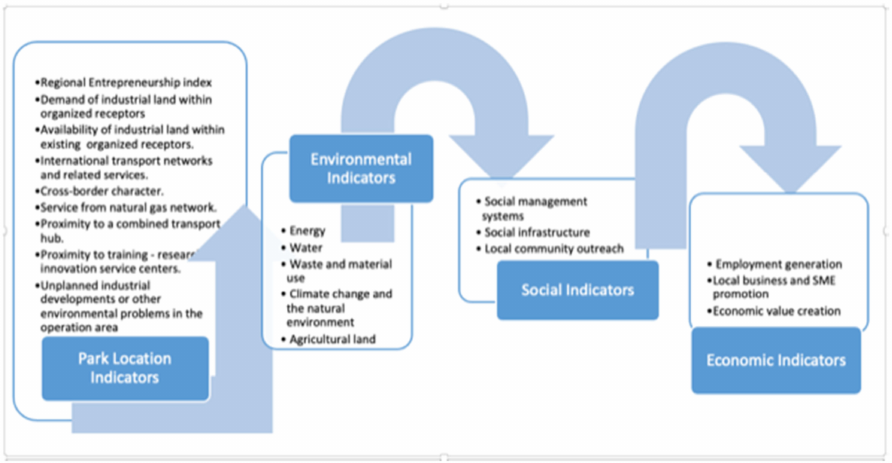
Figure 5. Schematic representation: necessary transformations of development and spatial policies for the modernization of Greek business parks. Source: Own